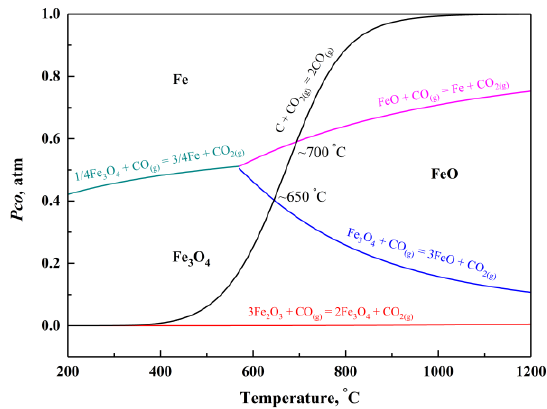
Figure 2. Equilibrium diagram of the reduction of iron oxides by CO.